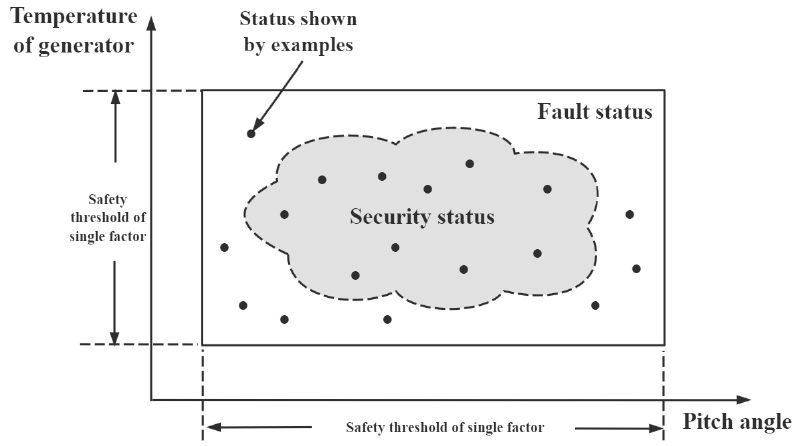
Figure 13. The security domain of the temperature of the generator and the pitch angle.